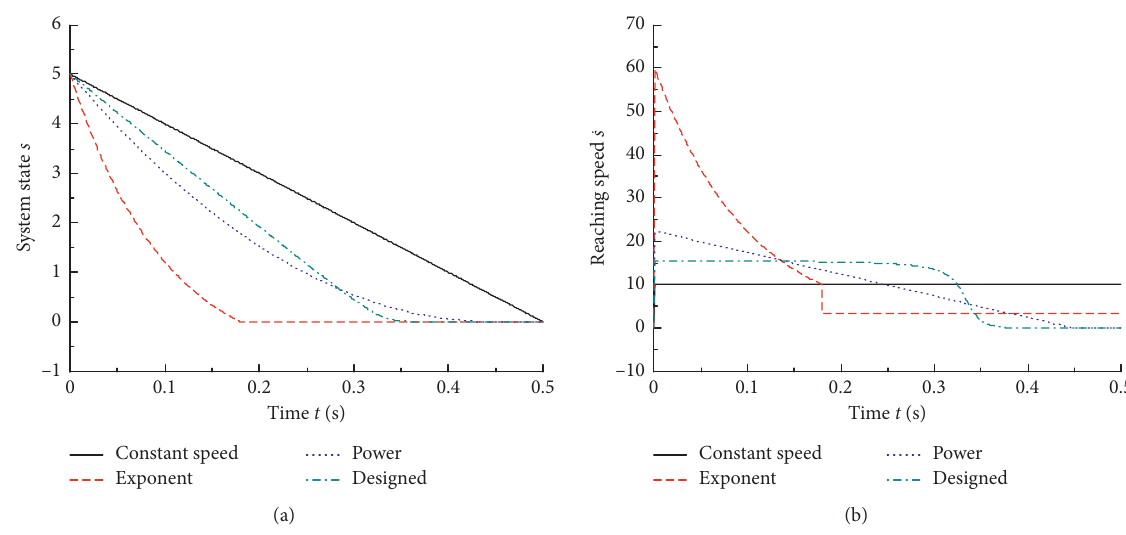
Figure 4: Reaching curves and approach speed when s � 5. (a) Reaching curves when s � 5. (b) Reaching speed when s � 5.